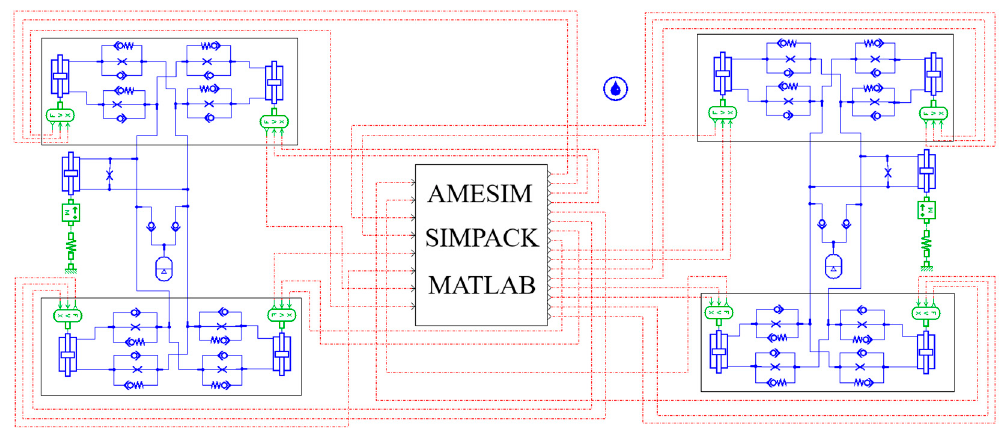
Figure 6. Scheme of the vehicle co-simulation platform.